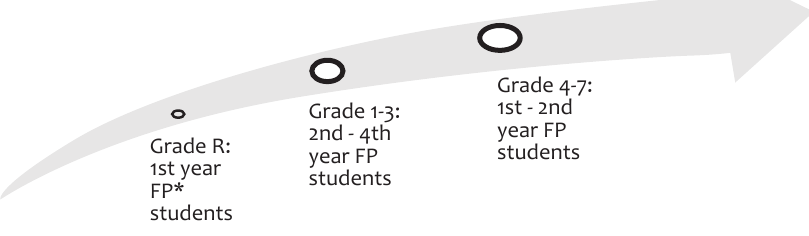
Figure 1: The Foundation Phase and the Intermediate phase curriculum in concord with learner cohorts in the